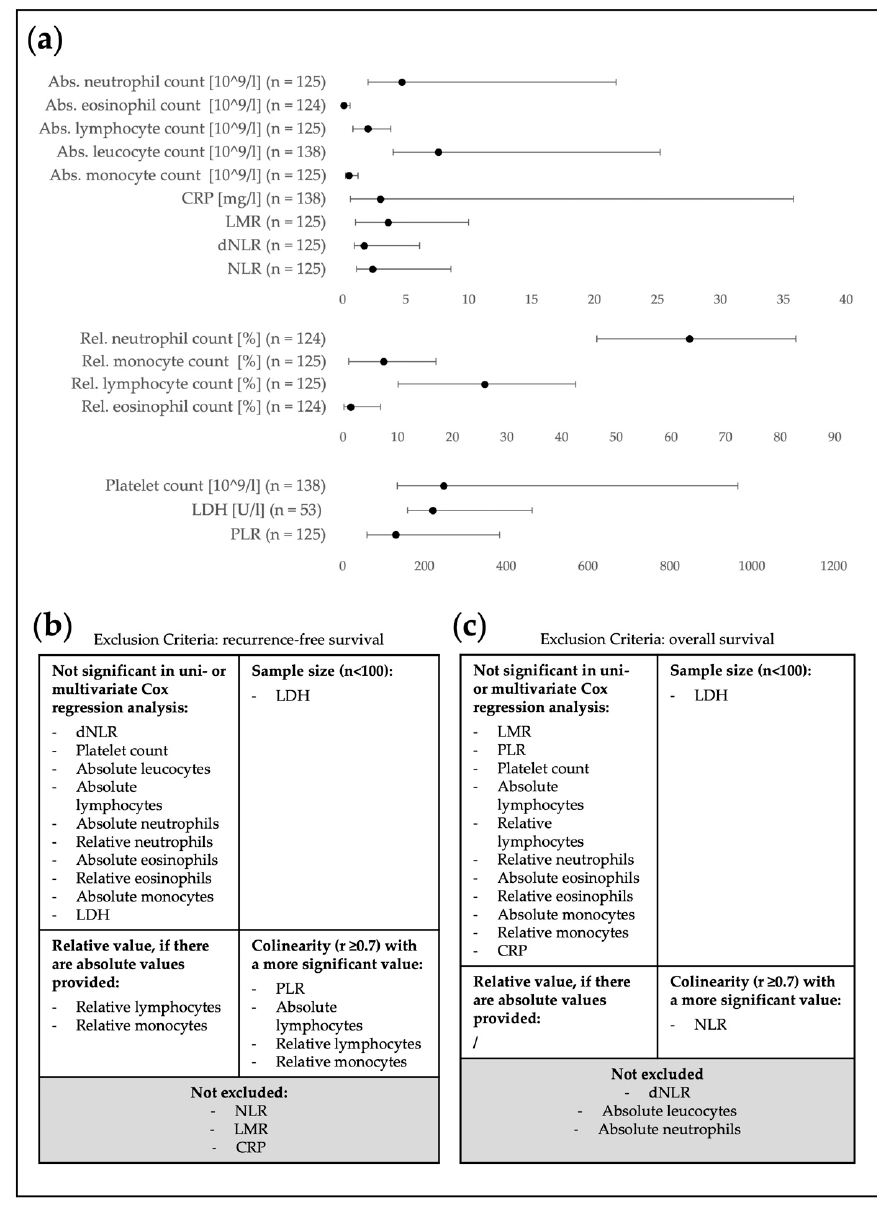
Figure 3. Overview of all blood values with applied exclusion criteria. Panel ( a ) shows a forest plot distribution of median values with 95% CI on three different scales. Panel ( b ) shows a list of ex- cluded blood parameters related to recurrence-free survival and panel ( c ) shows excluded parame- ters for overall survival. CRP: C-reactive protein, LMR: lymphocyte-to-monocyte ratio, NLR: neu- trophil-to-lymphocyte ratio, dNLR: derived NLR, LDH: lactate dehydrogenase, PLR: platelet-to- lymphocyte ratio.